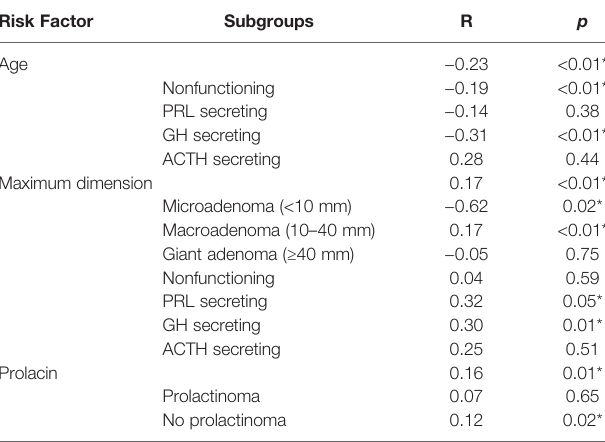
TABLE 4 | Subgroup analysis of correlation between the Ki-67 index and independent risk factors. Risk